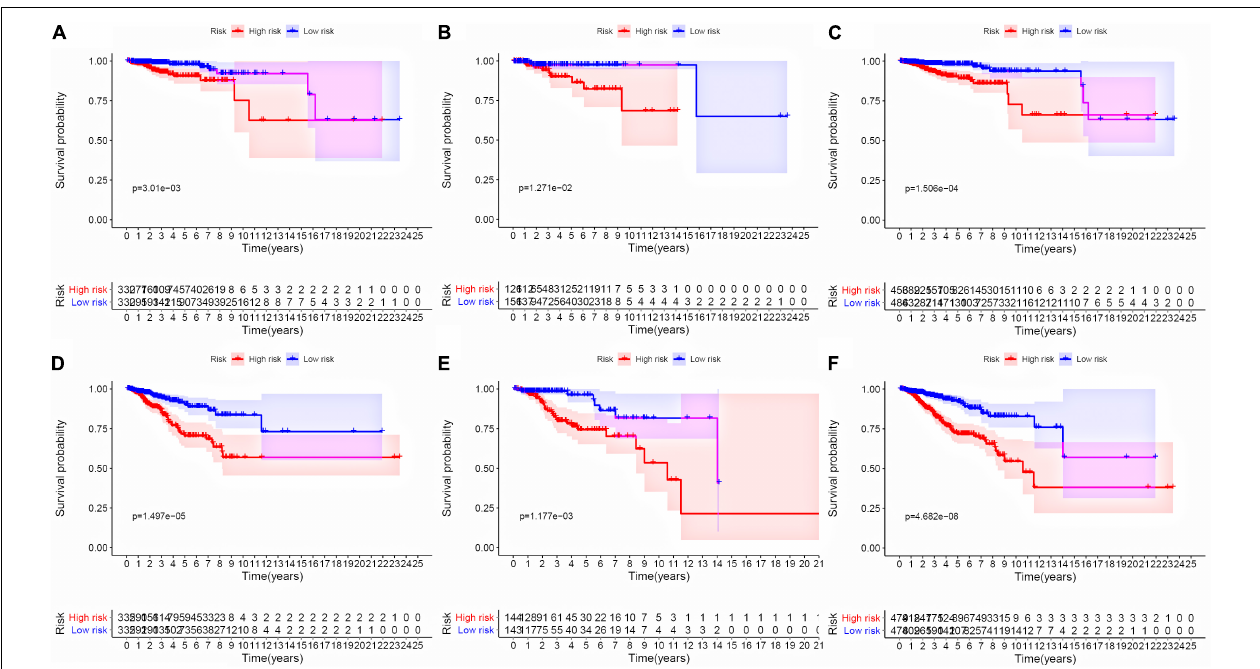
FIGURE 3 | Kaplan–Meier survival analysis between high groups and low groups. (A–C) Survival curves of BC patients from high-risk groups and low-risk groups in training, test, and whole sets based on the signature risk score for OS. (D–F) Survival curves of BC patients from high-risk groups and low-risk groups in training, test, and whole sets based on the signature risk score for RFS.